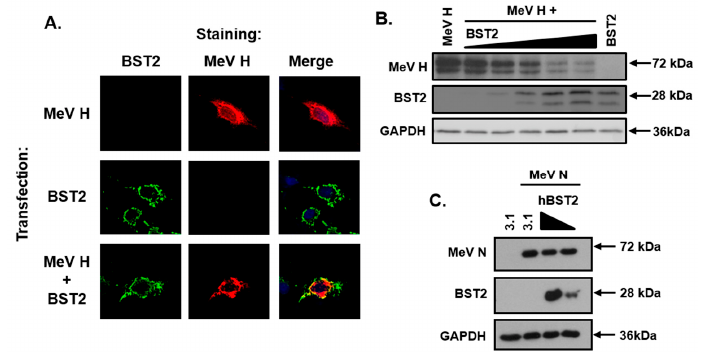
Figure 3. The MeV haemagglutinin glycoprotein is targeted by BST2. ( A ) Vero-hSLAM cells, cotransfected with the indicated pcDNA3.1-based expression constructs, and analyzed by immunofluorescence microscopy. Representative micrographs are shown together with merged images to demonstrate colocalization of labeled proteins. ( B/C ) 293-hSLAMs were transfected with 500 ng of pcDNA3.1-MeV nucleocapsid (N) or H and either pcDNA3.1, or, increasing amounts of pcDNA3.1-BST2 (ranging from 0 to 1.6 μ g) and analyzed by western blot. The total mass of transfected DNA remained constant.